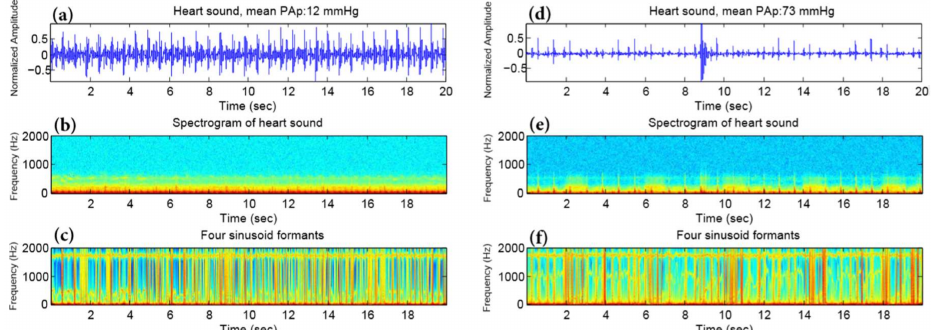
Figure 2. Spectrogram and four formants of heart sounds. ( a , d ) Heart sound recording, ( b , e ) spectrogram, ( c , f ) four sinusoid formants using the sine wave replica. At left, a subject with a mean pulmonary artery pressure of 12 mmHg, while at right a subject with a mean pulmonary artery pressure of 73 mmHg. In the bottom panel (four sinusoid formants), it is hard to distinguish the subject with pulmonary artery hypertension from the subject with normal pulmonary artery pressure. This contrasts with the bottom panel of Figure 6 in which the first sinusoid formant demonstrates a clear difference in the frequency distribution. Abbreviations: PAp = pulmonary artery pressure, sec = second, Hz = Hertz.